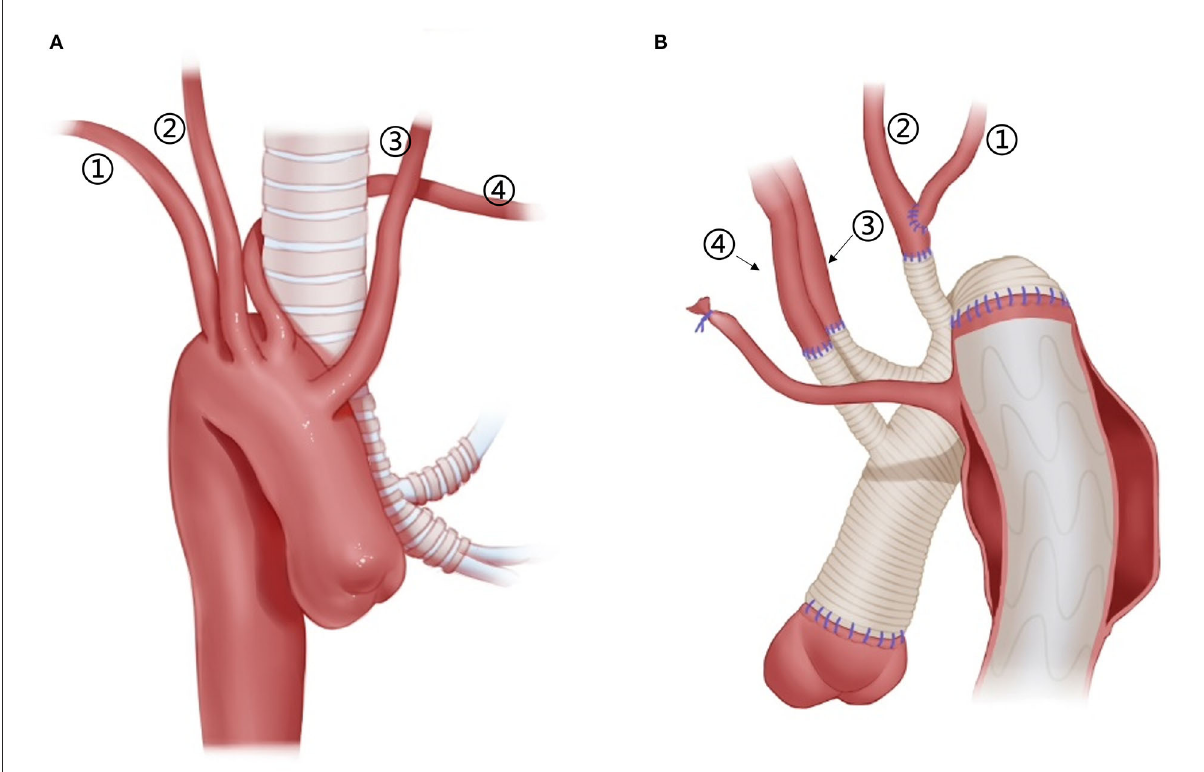
FIGURE5 Arch technique for patients with right arch and ALSA. (1) RSA; (2) RCCA; (3) LCCA; (4) ALSA. (A) Schematic diagram of the anatomy of the right arch + ALSA, from the front view. (B) Arch technique for a patient with right arch + ALSA, from the posterior view. ALSA, from the posterior